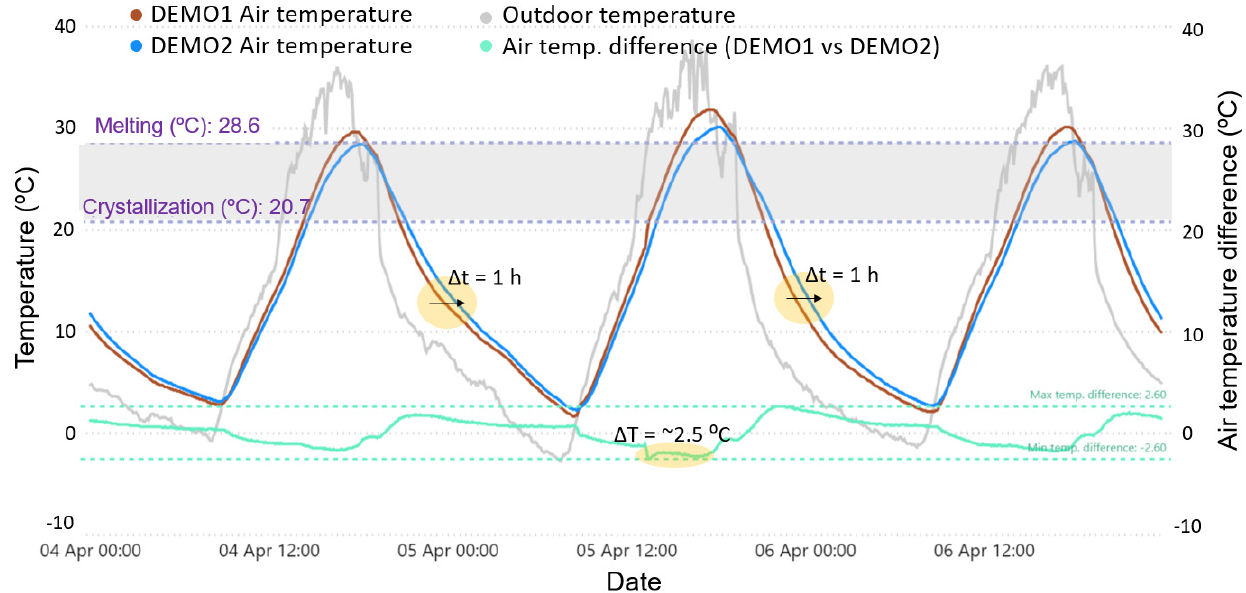
Figure 10. Comparison of room air temperature values at DEMO1 (reference cell without PCM) and DEMO 2 (test cell incorporating CrodaTherm-based panels). Zoom on three consecutive days on the 2nd week of April 2021. In light green, the room temperature difference between both cells is shown.